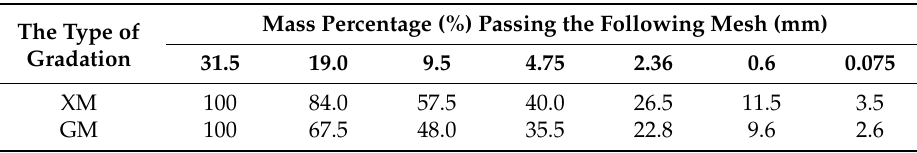
Table 4. Two design gradation of percentage (%) passing of key